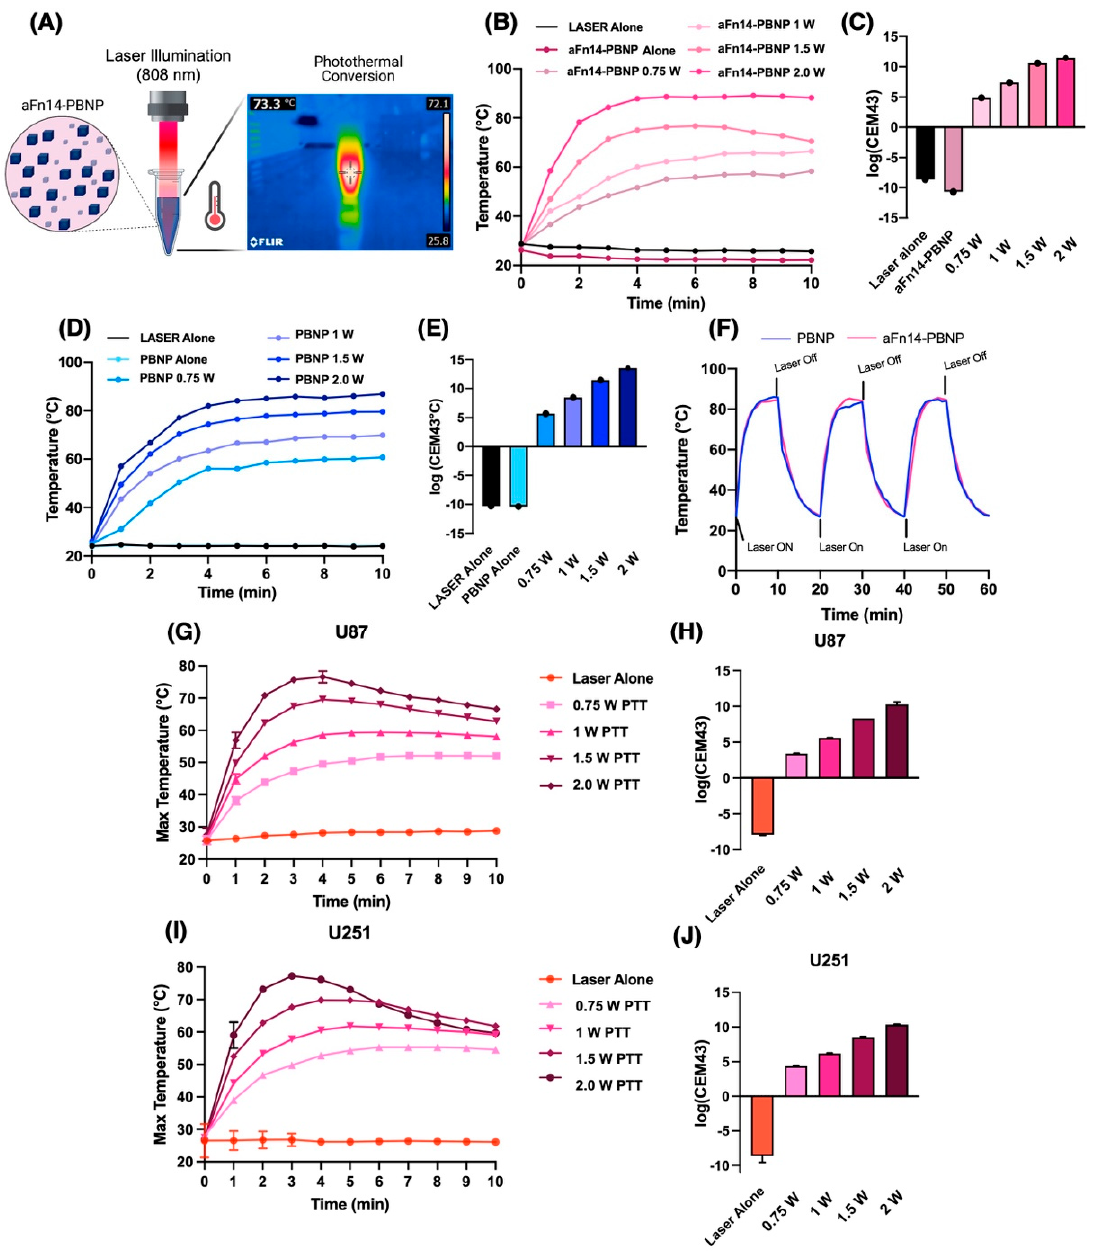
Figure 2. Conjugation to aFn14 does not alter the PTT properties of PBNPs, and aFn14-PBNPs can be used to administer a range of thermal doses to U87 and U251 GBM tumor cells. ( A ) Schematic of the PTT studies as described in Methods 2.6. Water or U87 or U251 cells in media were treated with 0.15 mg/mL PBNP or aF14-PBNP and then irradiated with an 808 nm laser. ( B ) Heating curves of aFn14-PBNP as a function of laser power. ( C ) Thermal doses delivered by aFn14-PBNPs as a function of laser power. ( D , E ) Heating curves ( D ) and thermal doses I delivered by PBNPs as a function of laser power. ( F ) Cyclic heating of PBNPs and aFn14-PBNPs over 3 heating-cooling cycles. ( B – F ) PTT properties of PBNP and aFn14-PBNP are similar, indicating that conjugation to aFn14 does not negatively affect PBNP PTT properties. ( G ) Heating curves ( H ) and thermal doses delivered to U87 GBM cells by aFn14-PBNPs as a function of laser power. ( I ) Heating curves ( J ) and thermal doses delivered to U251 GBM cells by aFn14-PBNPs as a function of laser